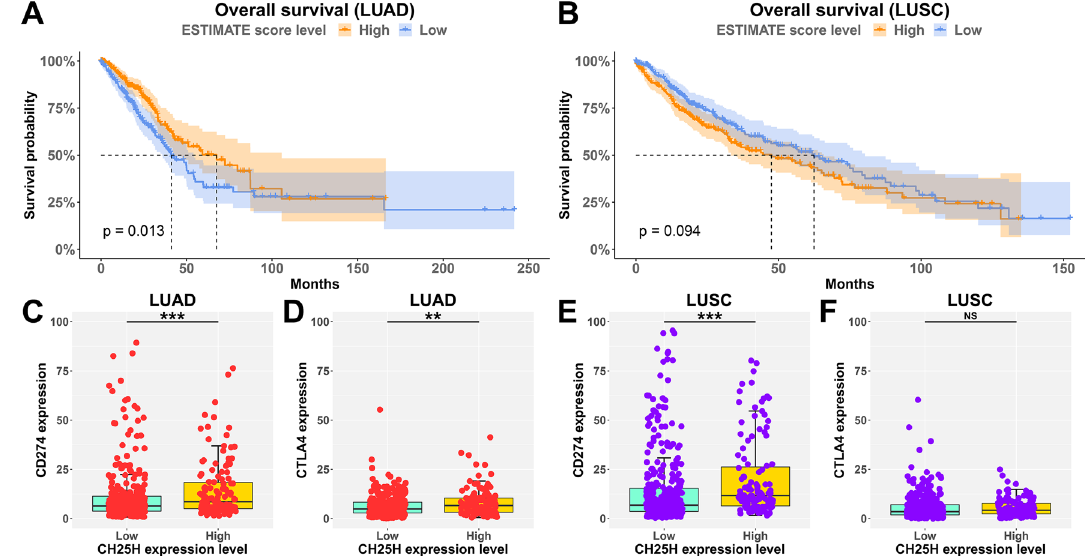
Figure 4. Association of immune score and OS, CH25H expression and immunotherapy markers. ( A , B ) Kaplan–Meier survival curves analysis showed that patients with high immune scores had higher overall survival time in TCGA-LUAD; ( C – F ) box plot showed that patients with high CH25H expression had high immunotherapy markers (CD274 and CTLA4) expression in LUAD. “**”, “***” and “NS” indicate p < 0.01, p < 0.001 and p > 0.05, respectively.